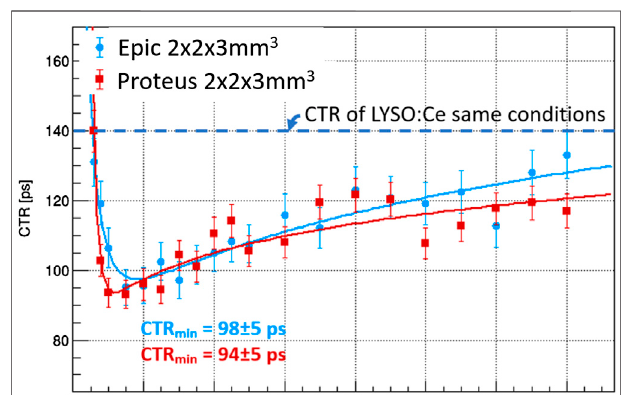
FIGURE 7| CTR measurements of 2 × 2 × 3mm 3 BaF 2 pixels from Epic and Proteus, air coupled to a S13370-CN SiPM from Hamamatsu, operated at 61 V. For both fi ts of the data, the minimum value is written in the corresponding color.